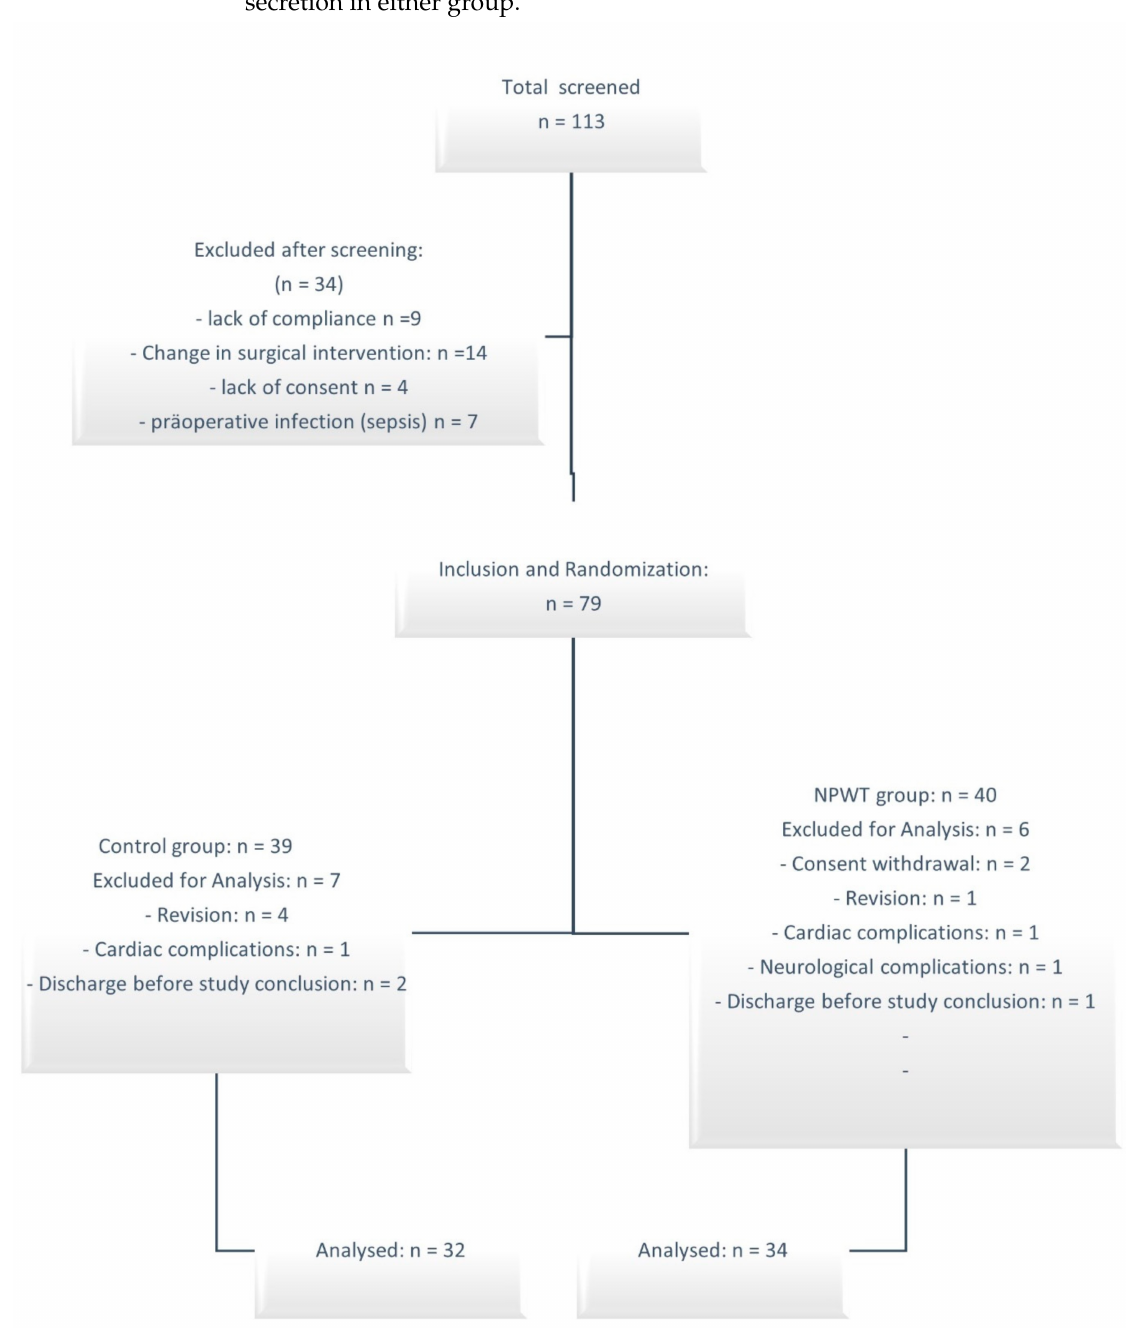
Figure 1. Exclusion